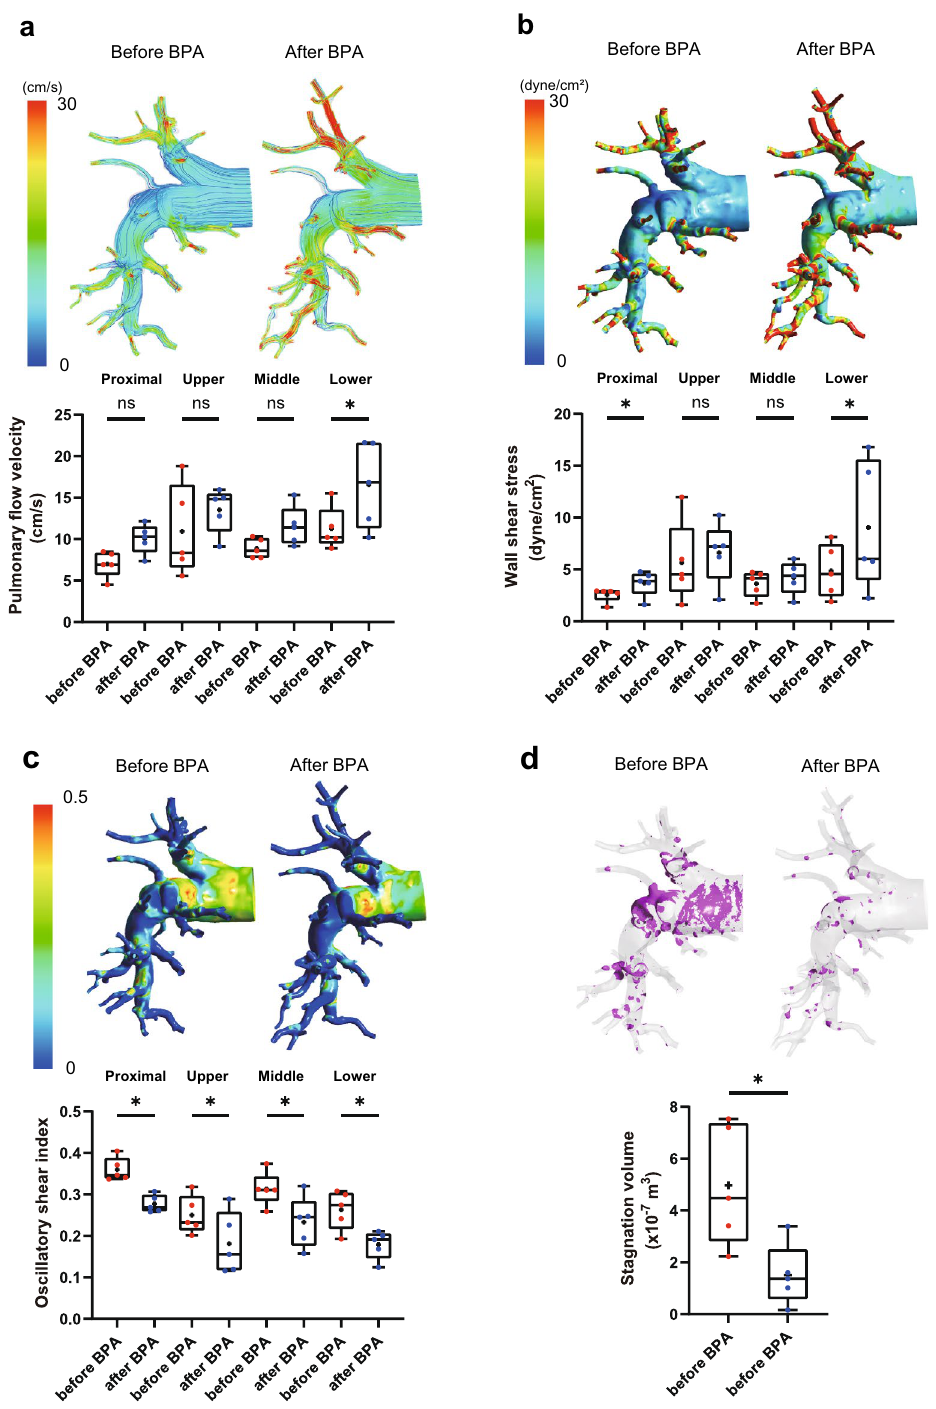
Figure 5. Pulmonary blood flow dynamics before and after BPA. Pulmonary flow velocity ( a ), wall shear stress ( b ), oscillatory shear index ( c ), and blood stagnation volume ( d ) were simulated by CFD in the pulmonary arteries of patients in comparison of before and after BPA. Stagnation was defined as flow velocity of < 0.01 m/s. Data are presented as the median (interquartile range). Cross indicates mean. The numbers in each box plot indicate the sample size for each group. *p < 0.05 compared to before BPA; ns, not significant; BPA, balloon pulmonary